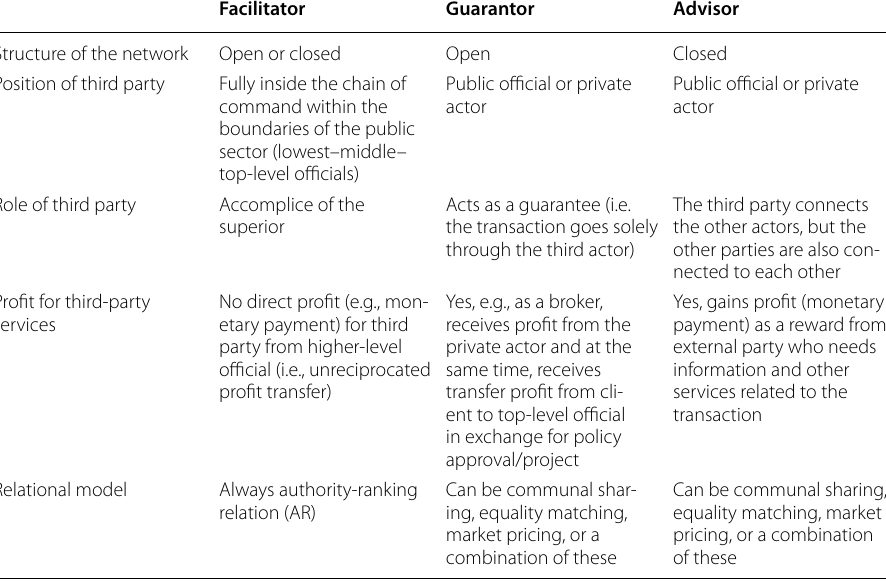
Table 2 Characteristics of the third party in corruption